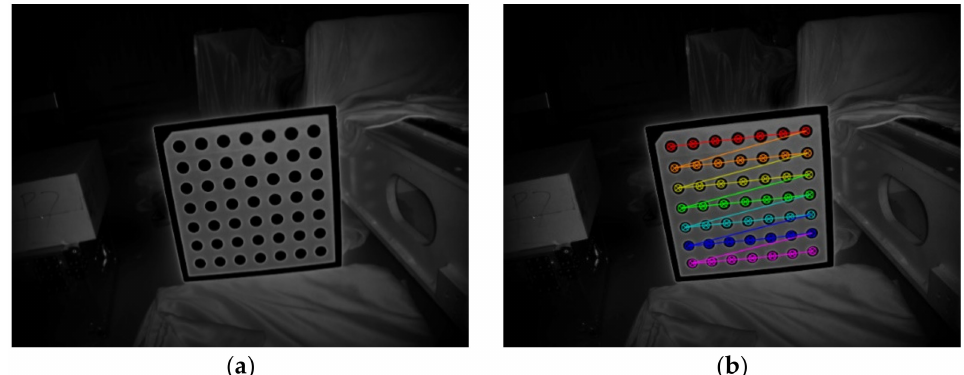
Figure 2. Schematic diagram of the TOF camera calibration. ( a ) Near-infrared intensity image; ( b ) dot detection result.